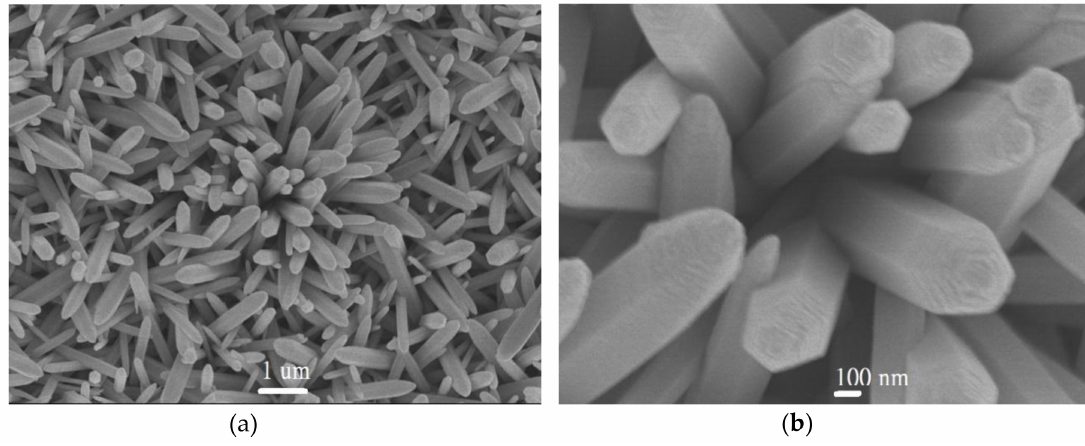
Figure 2. SEM images of ZnO nanorods / PEEK sample at ( a ) 10 k(X) and ( b ) 50 k(X),